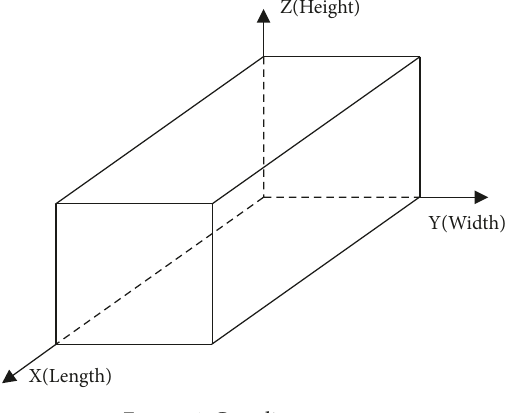
Figure 1: Coordinate system.